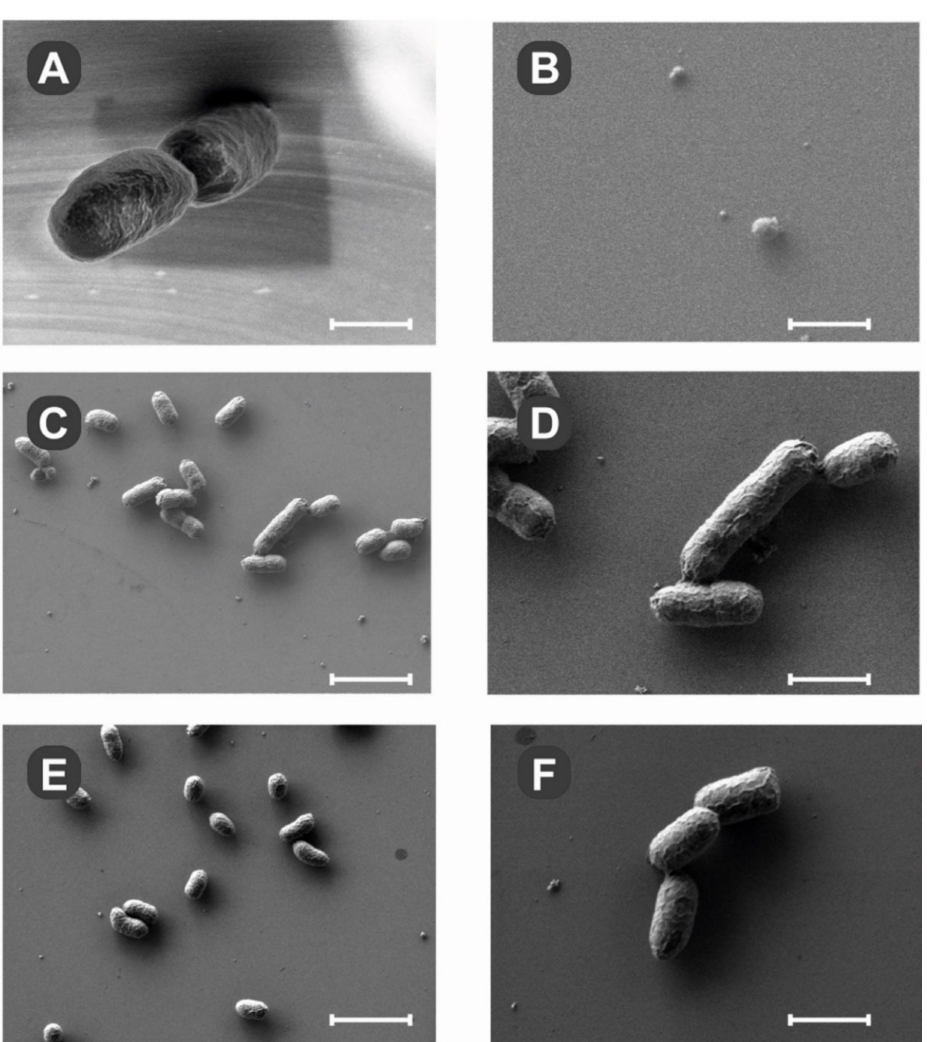
Figure 3. Scanning electron microscopy of drug-resistant Y. enterocolitica strain 2080. The SEM was performed on bacteria passaged at least nine times in the presence of 200 µ M compound 1 ( B ), 7 ( C , D ), or 3 ( E , F ), and deposited on polished silicon chips as described in Materials and Methods. Bacteria grown without targeting compounds displayed normal morphology ( A ). After exposure to compound 1 for nine passages, there were only fragments of organic debris visible ( B ). In the presence of compounds 7 and 3, there were multiple bacteria observed with apparently normal morphology. Scale bars: ( A ) and ( B ) 500 nm, ( C ) and ( E ) 2.5 µ m, ( D ) and ( F ) 1 µ